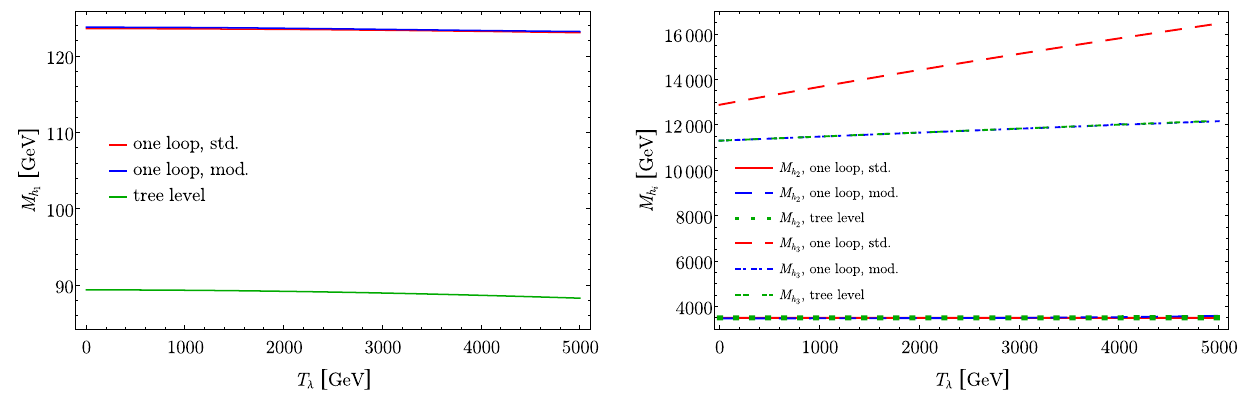
Fig. 9 M h (left) and M h and M h (right) as a function of λ , in sce- 1 2 3 nario 1. The other inputs are taken as in Table 1. Tree-level values are shown with green curves, while the red and blue curves correspond to